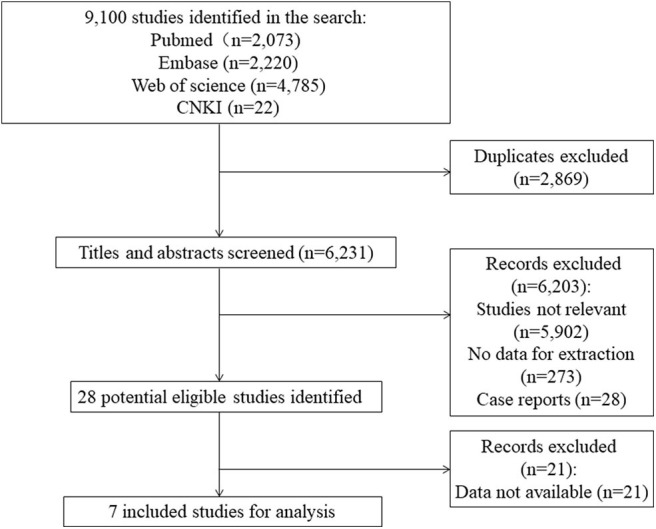
Flow diagram of study selection.